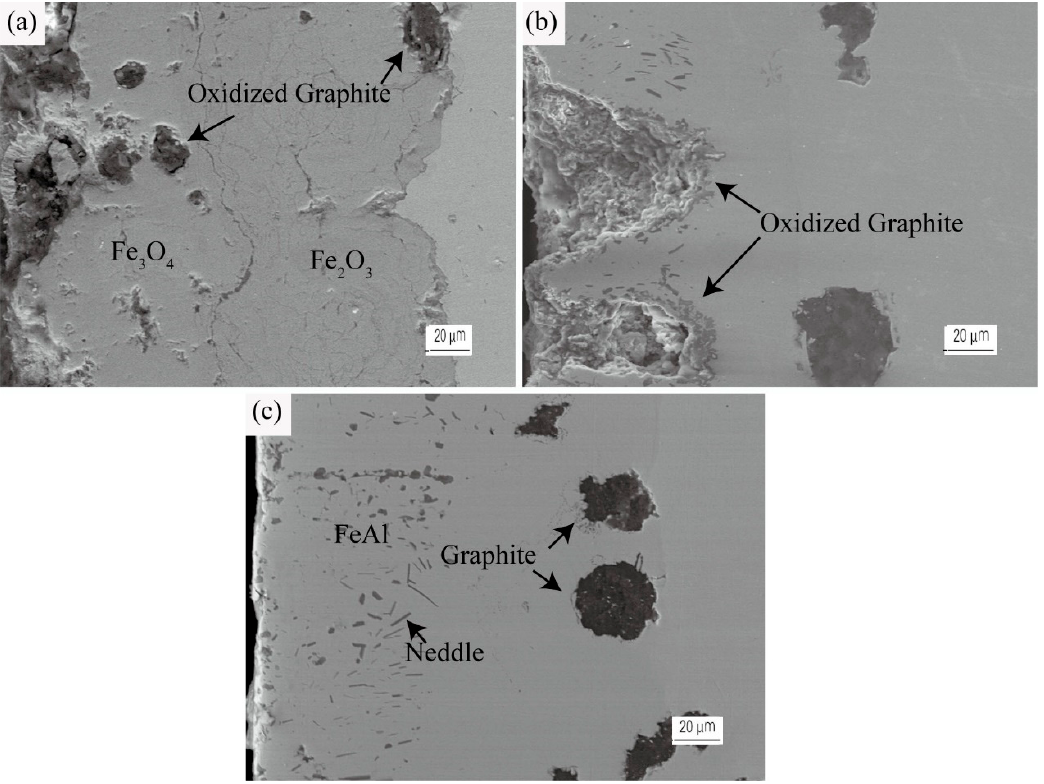
Figure 9. The cross-sectional micrographs of samples after the 750 °C oxidation for 72 h ( a ) spheroidal graphite cast iron ( b ) and ( c ) spheroidal graphite cast iron after pack aluminizing.